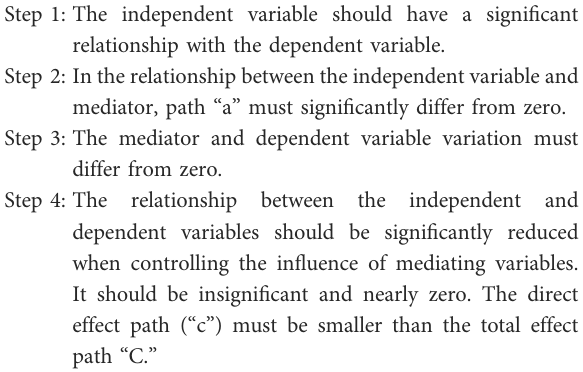
FIGURE 1 Conceptual